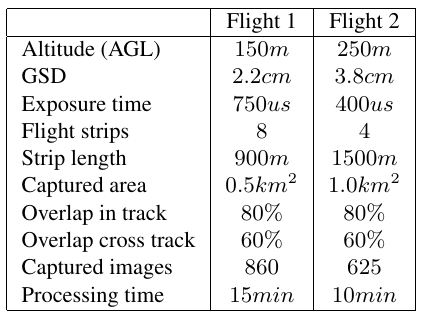
Table 1. Key figures of performed test flights